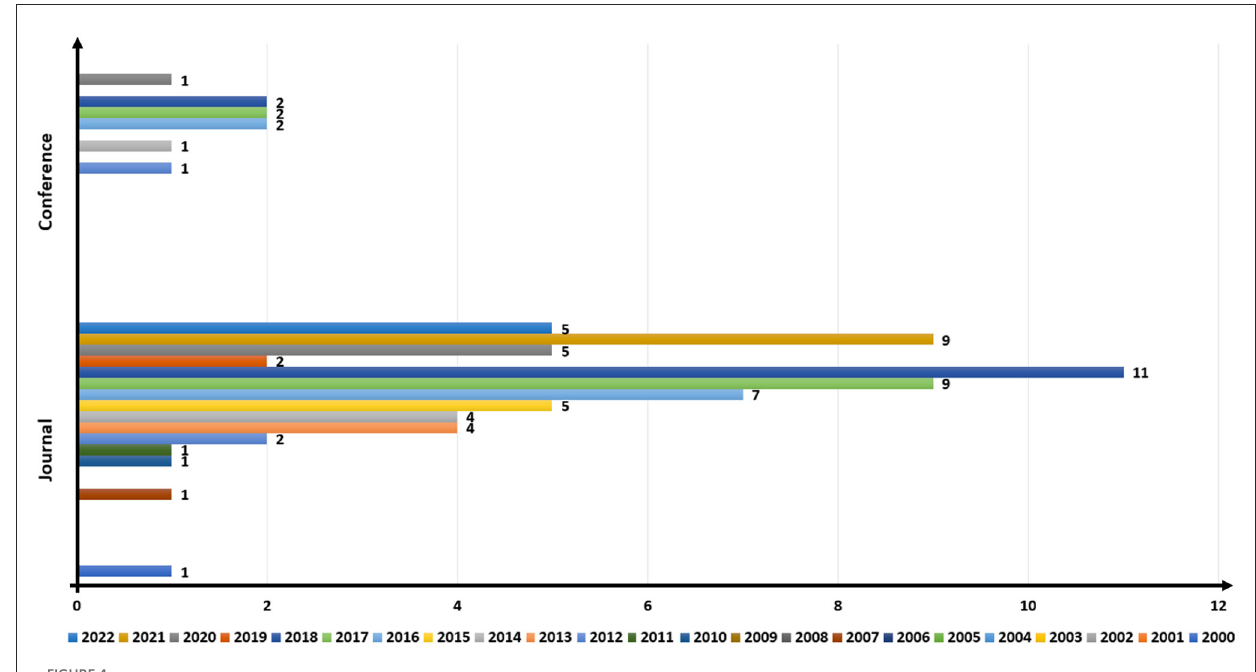
FIGURE4 Yearly publication trend based on the research